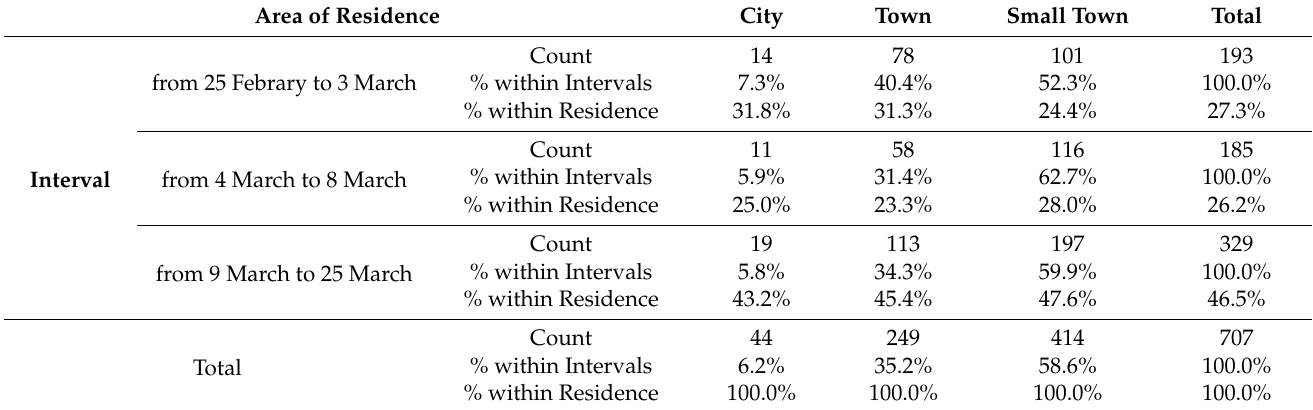
Table 1. Time interval in relation to participants’ area of residence.